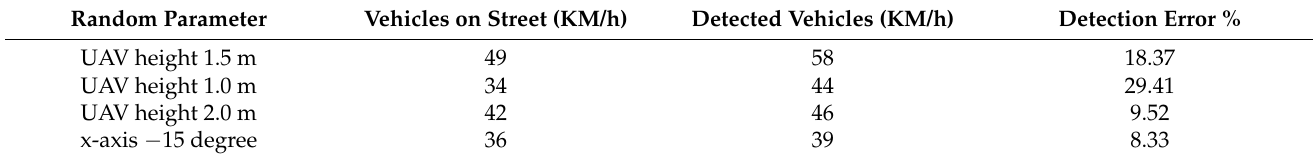
Table 10. Vehicle detection accuracy on the system random